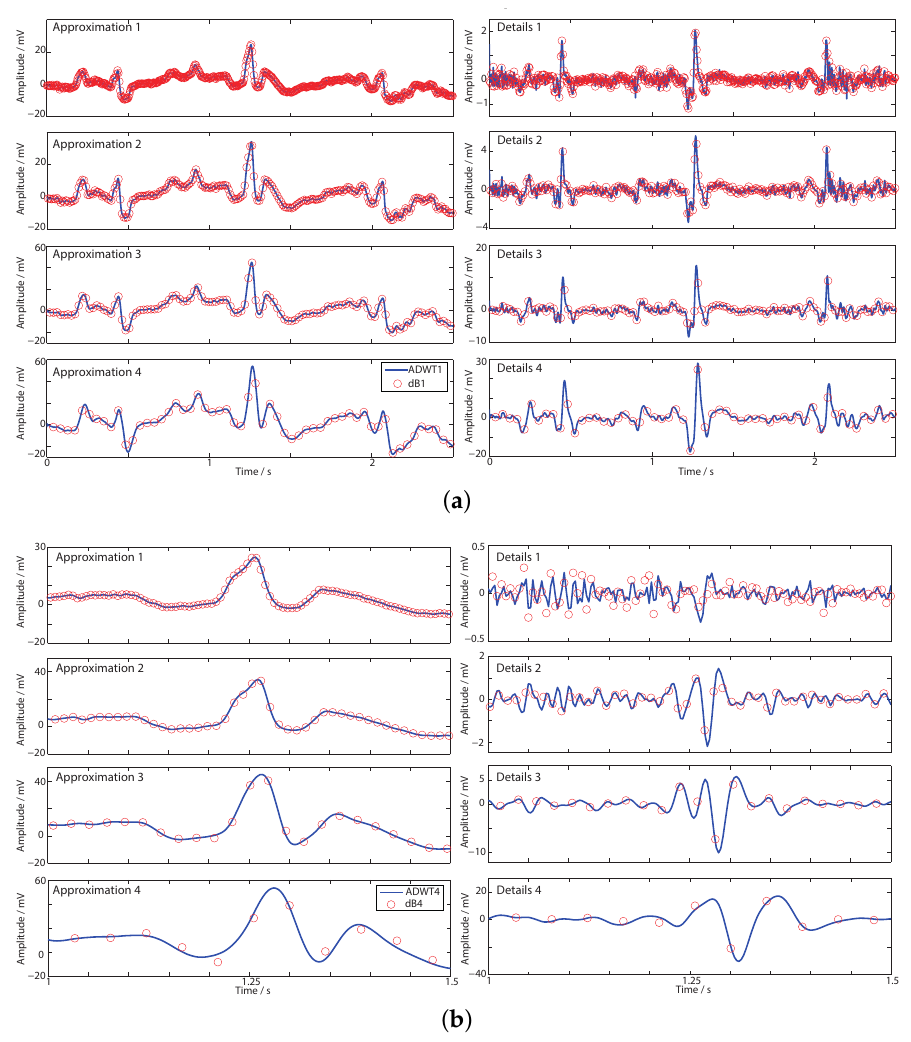
Figure 6. Transient responses of the DWT and ADWT show that the DWT is sampling different points along the underlying ADWT continuous time output. ( a ) First order ADWT1 and dB1; ( b ) Fourth order ADWT4 and